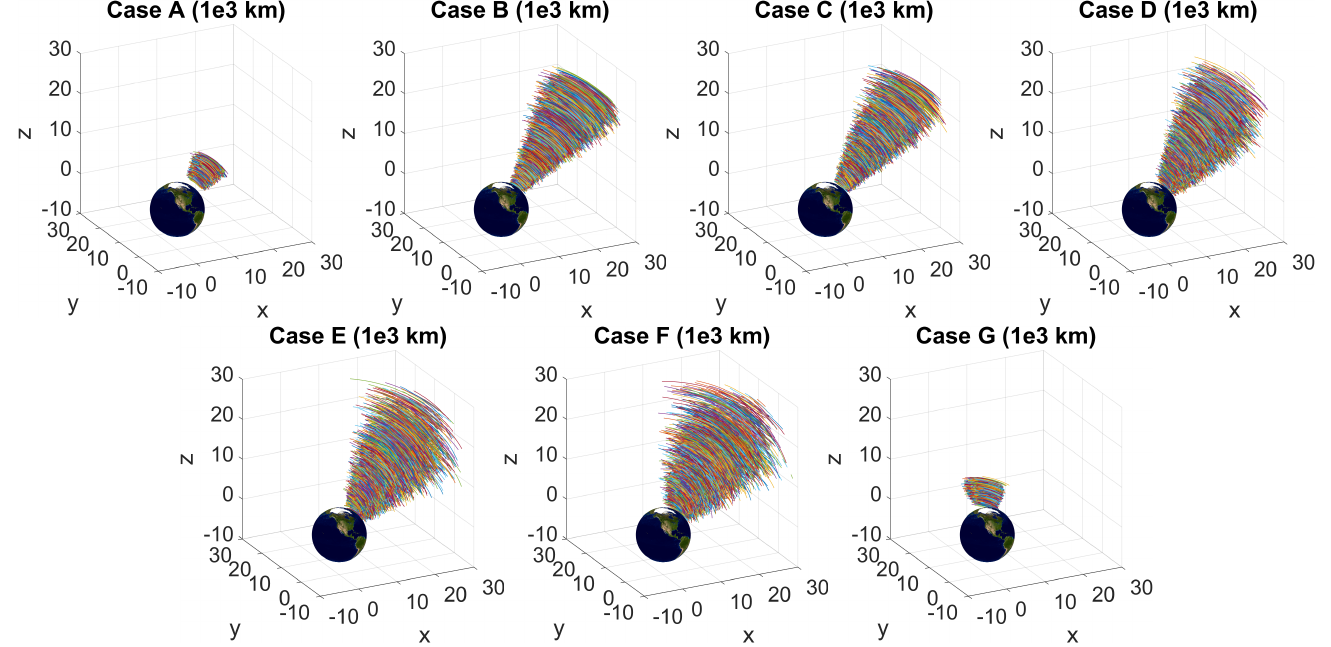
Figure 3. Orbital arcs for 5000 test orbits of the different orbital case